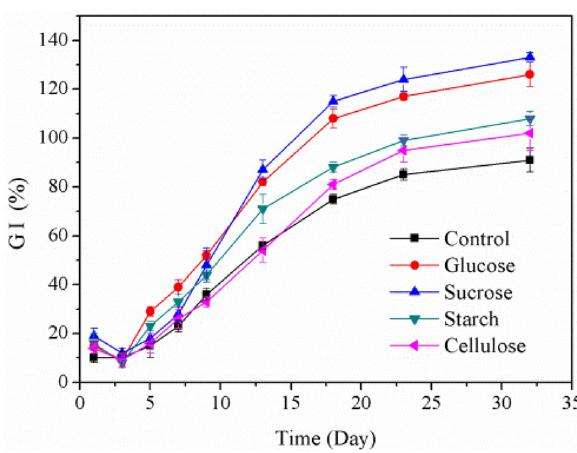
Figure 4. Evolution of GI in five